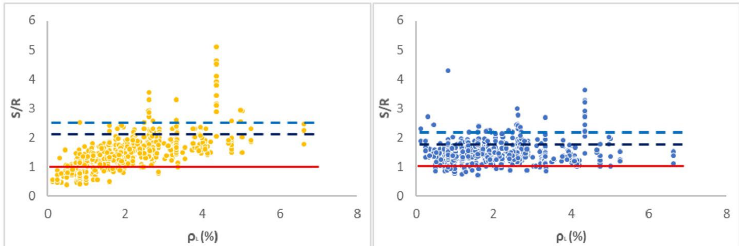
Figure 6- S/R in relation to